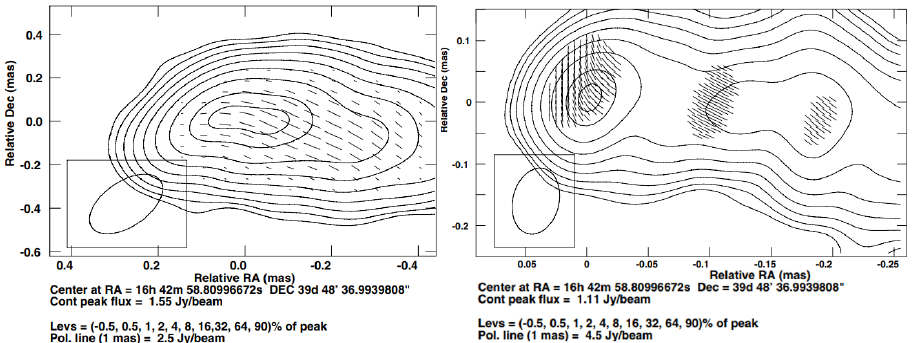
Figure 1. Global mm-VLBI Array (GMVA) image (at 3mm, left ) and Very Long Baseline Array (VLBA) image (at 7mm, right ) of 3C345 (adapted from [20]; reproduced with permission from A&A, ESO). Notice how the higher GMVA resolution allows us to disentangle several compact polarized components across the jet, with a polarization rotation towards the core.